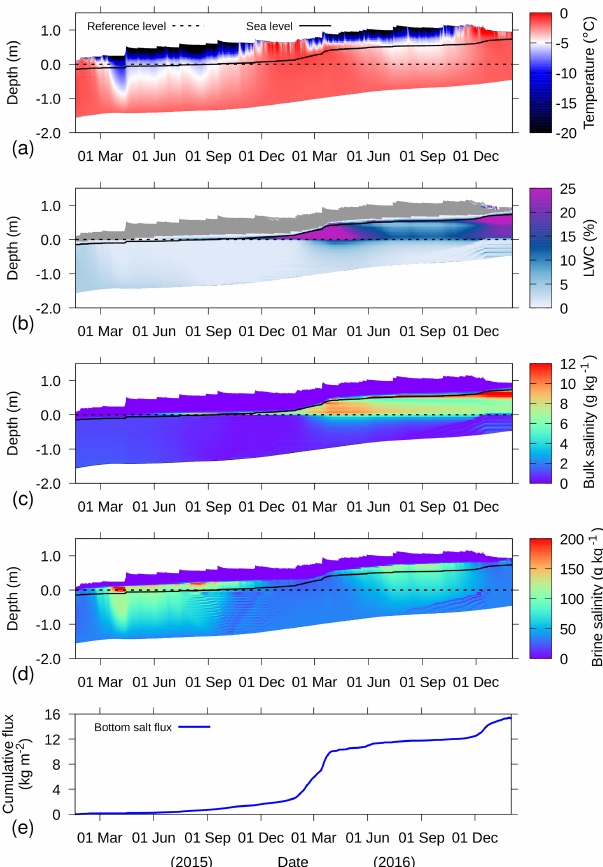
Figure 8. Example simulation for buoy 2014S12, where measured snow depth was used to derive the precipitation events, for (a) tem- perature, (b) LWC, (c) bulk salinity, (d) brine salinity, and (e) cu- mulative salt flux at the bottom of the sea ice. In (b) , dry parts of the snow–sea-ice system are colored grey. In (a–d) , the depth is defined relative to the snow–ice interface, as determined upon installation (dashed line). The solid line denotes the sea level as determined by the simulation. In (e) , an increasing cumulative flux denotes inflow and vice